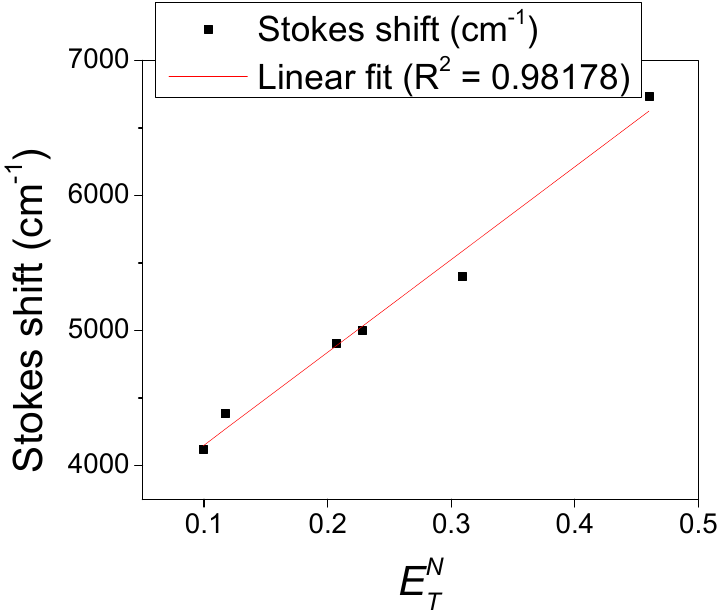
Figure 2. Effect of solvent polarity ( E 𝑇𝑁 ) on the observed Stokes shift for chemosensor 4 in different solvents (black dots), with the corresponding linear trend (red line).